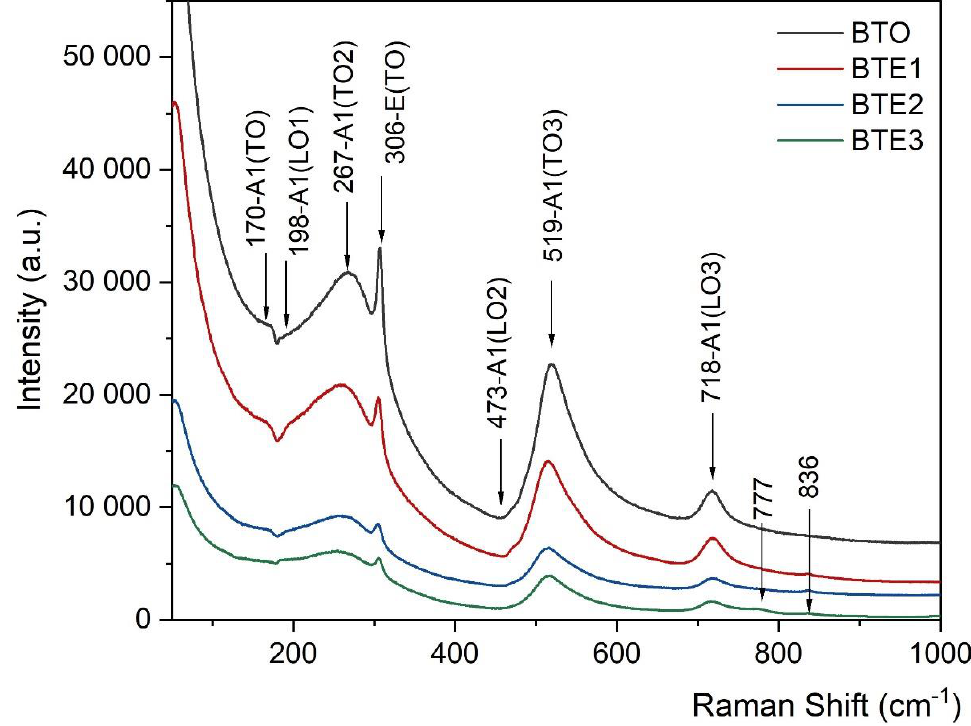
Figure 8. Room temperature Raman spectra of the pure BTO and for BTEx (BTE1, BTE2, BTE3) ce- ramics.